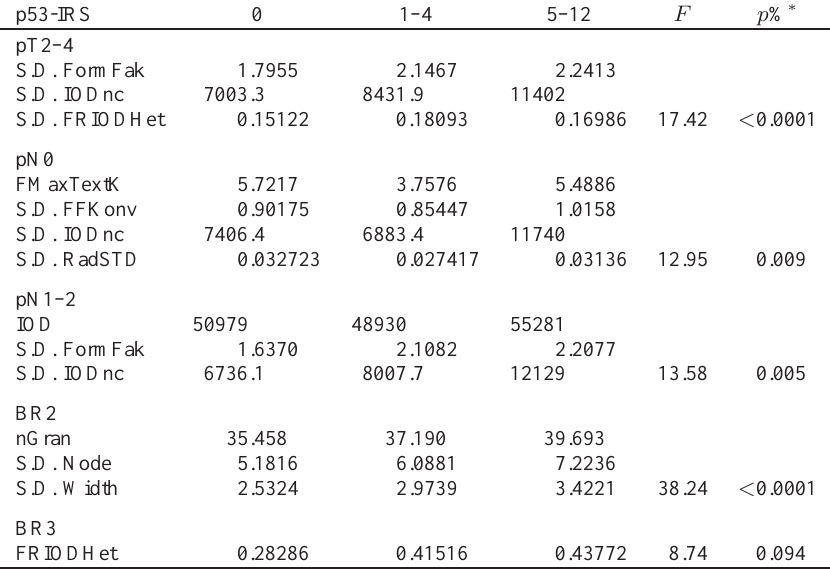
Table 5 Tumours with different p53 expression in clinicopathological